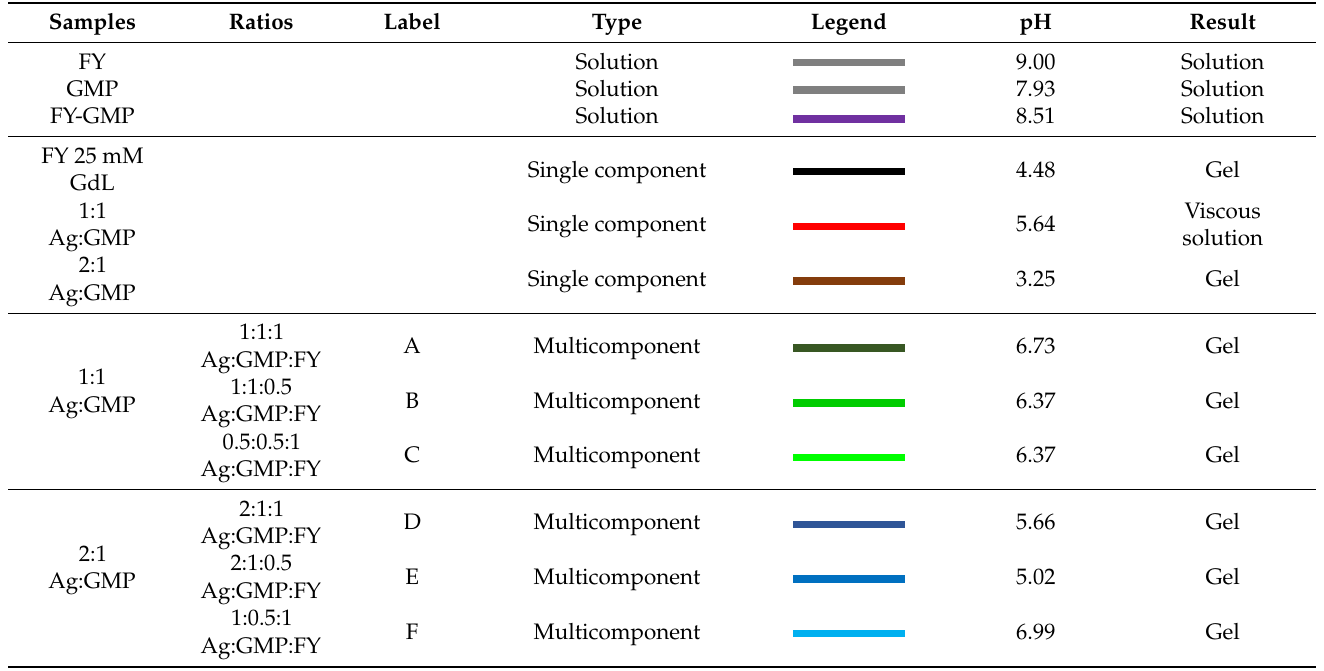
Single component